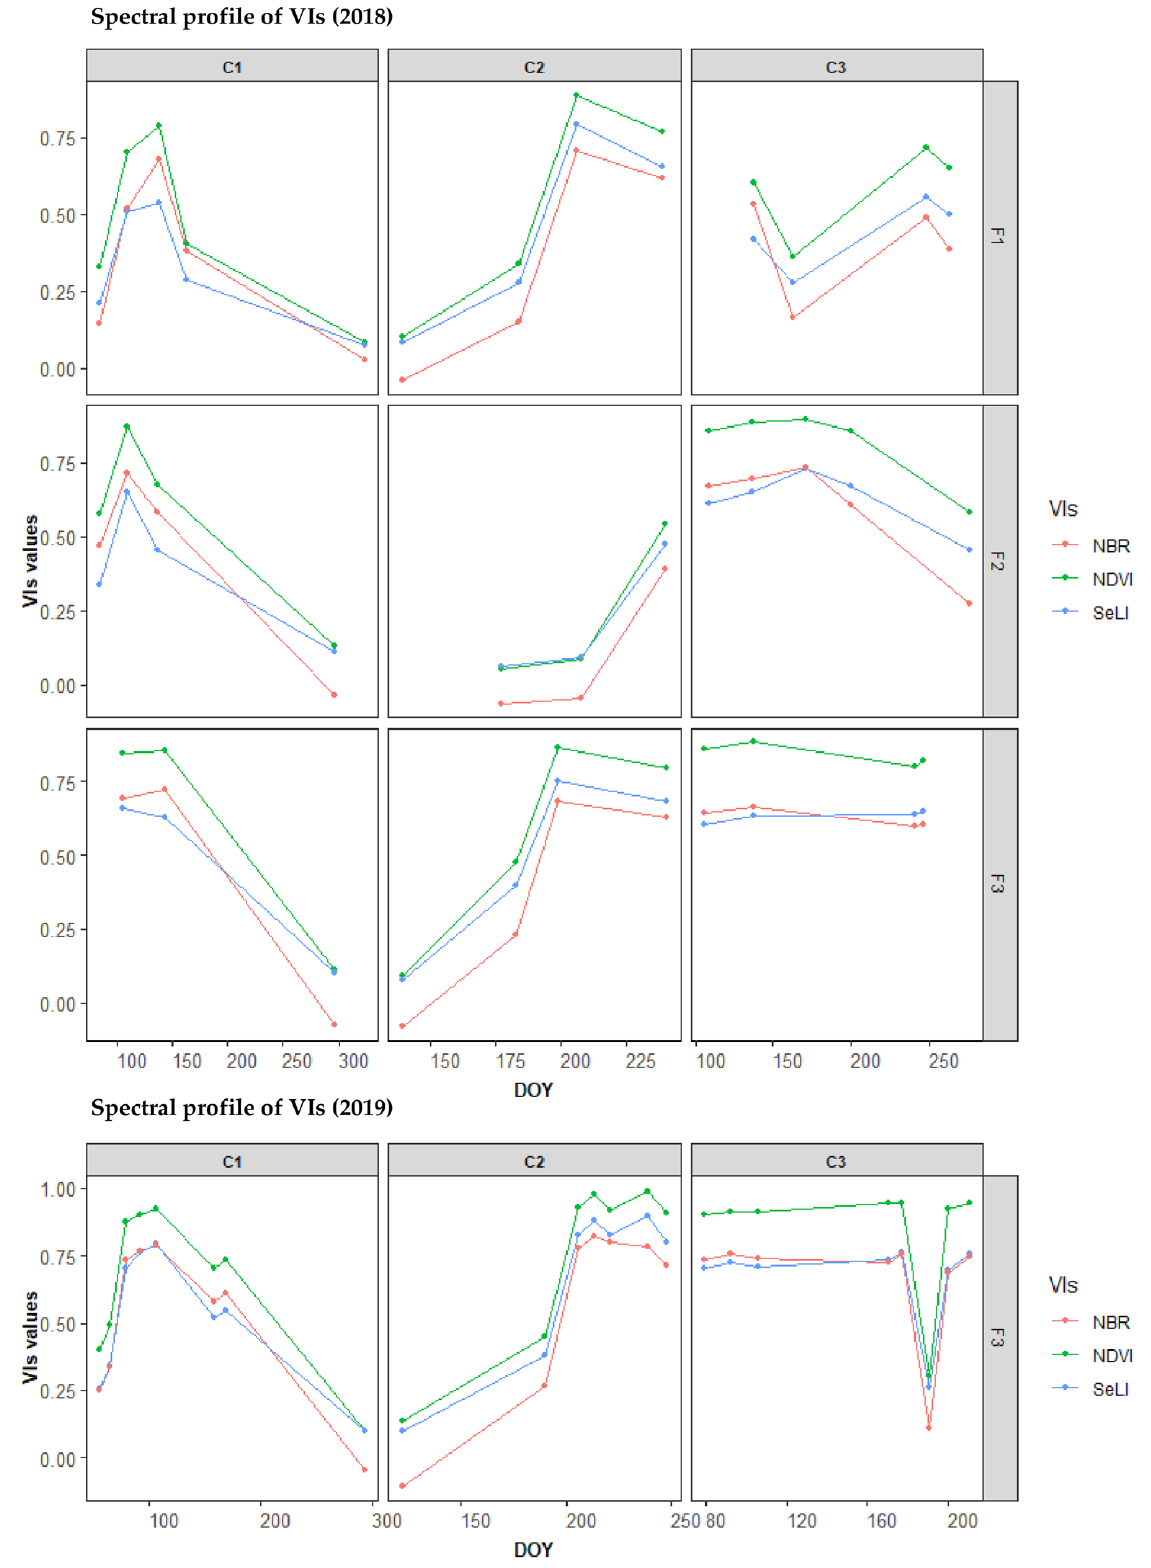
Figure A4. Multitemporal profile of VIs (NBR, NDVI, and SeLI) for the two-year ground-LAI sampling campaign.